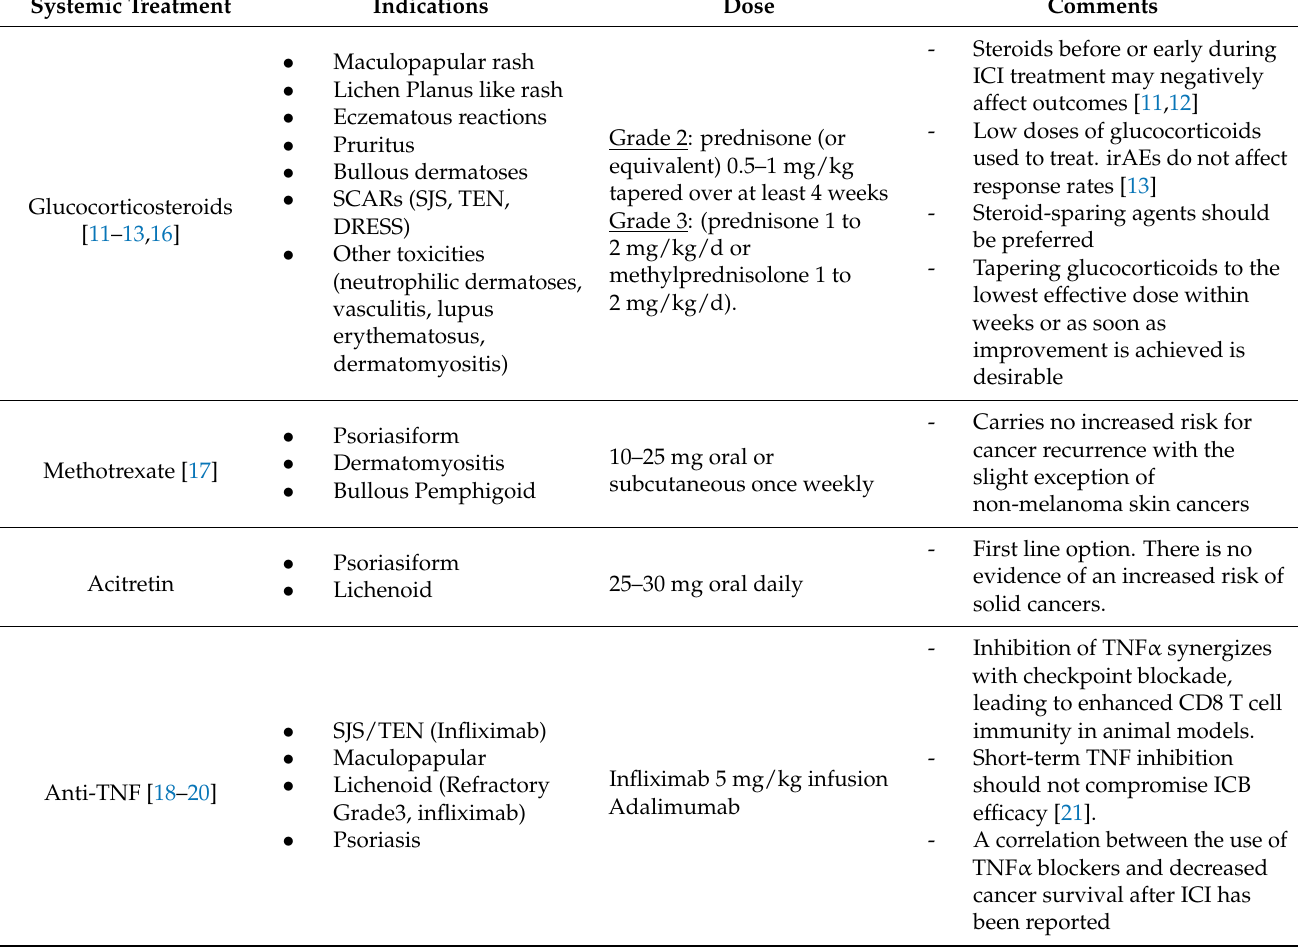
Table 1. Most commonly used systemic agents used for the treatment of cutaneous irAEs. Systemic Treatment Indications